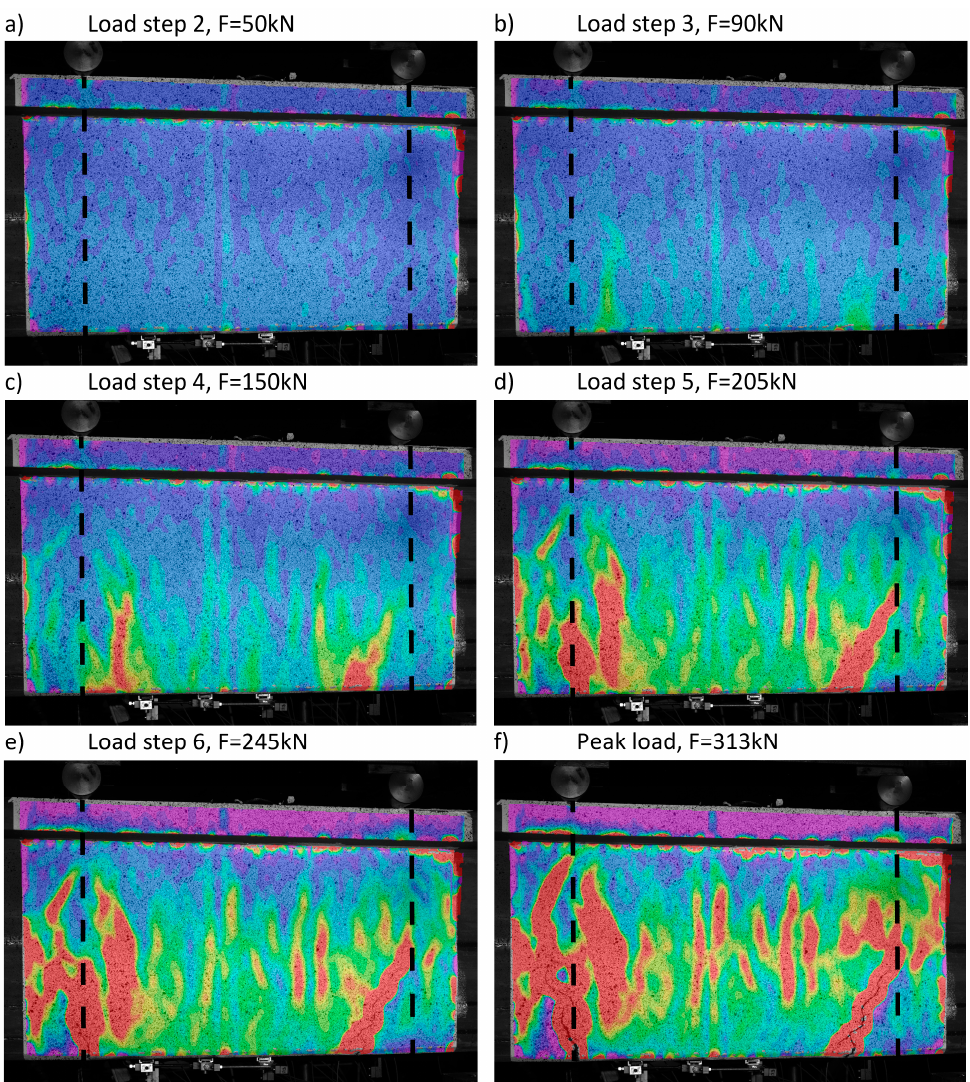
Figure 9. Strain distribution obtained with DIC for different load steps: ( a ) LS2, ( b ) LS3, ( c ) LS4, ( d ) LS5, ( e ) LS6, ( f ) Peak load; ε xx with scale as in Figure 8; the constant bending moment zone is marked with dashed lines.